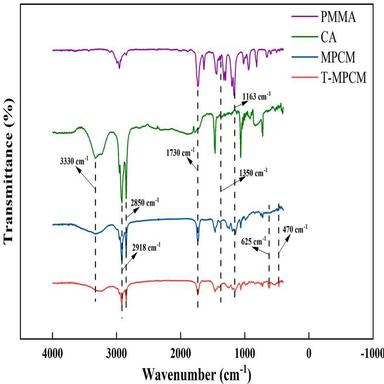
FTIR spectra of PMMA, CA, MPCM and T-MPCM.